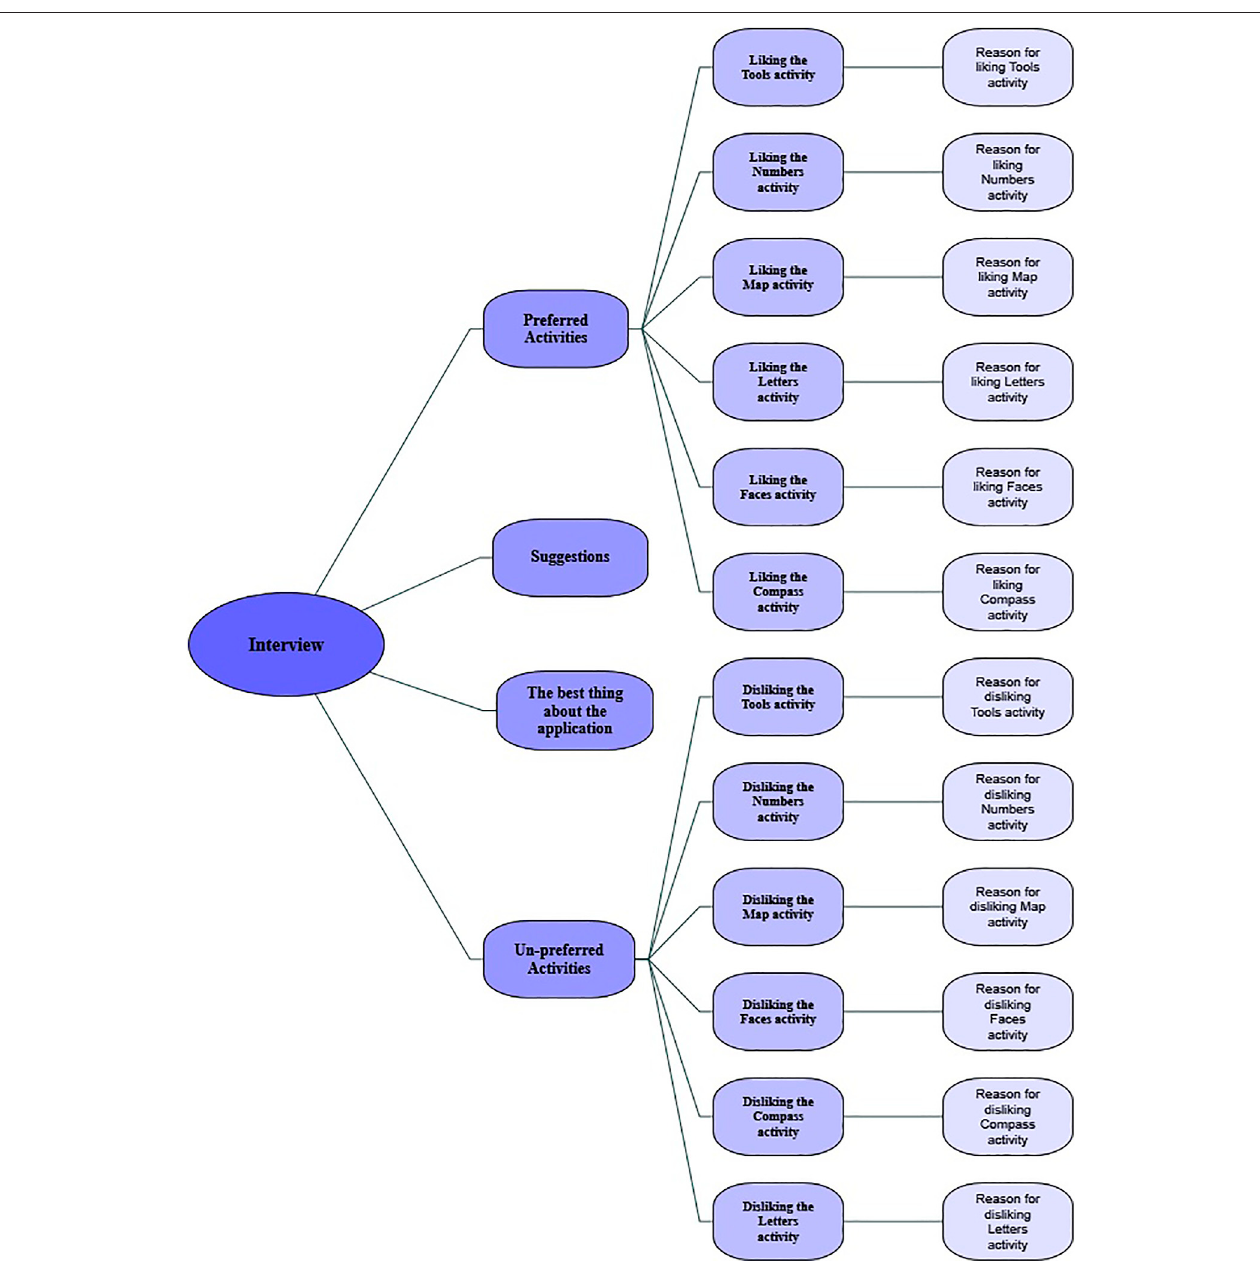
FIGURE 1 | Overarching thematic map for the interview-based questionnaire shows the four global interview ’ s themes and its individual thematic networks.